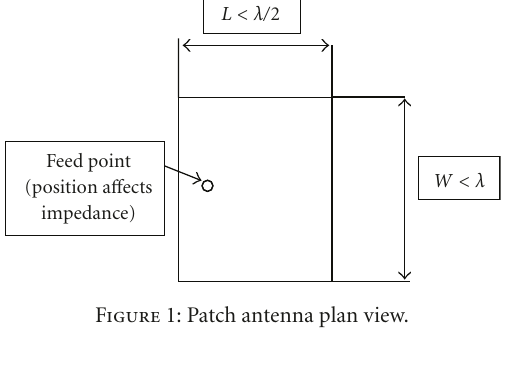
Figure 1: Patch antenna plan view.